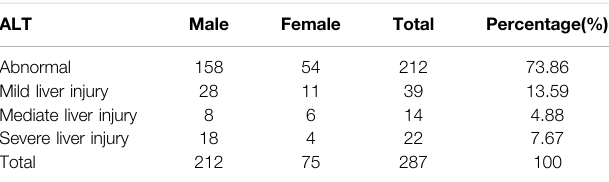
TABLE 3 | First-time liver function test results of all subjects after the start of anti- TB drug treatment. ALT Male Female